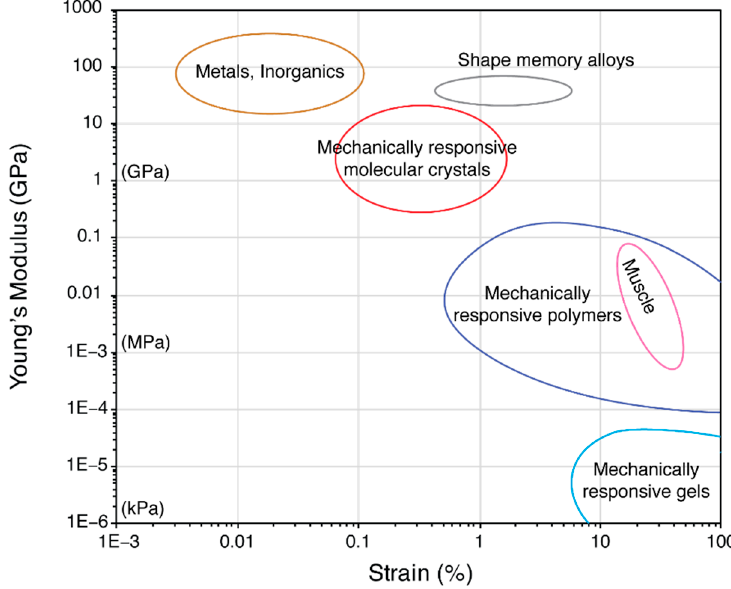
Figure 2. Relationship between the Young’s modulus and strain of actuator materials. Reprinted with permission from [22]. Copyright 2019 Wiley-VCH.